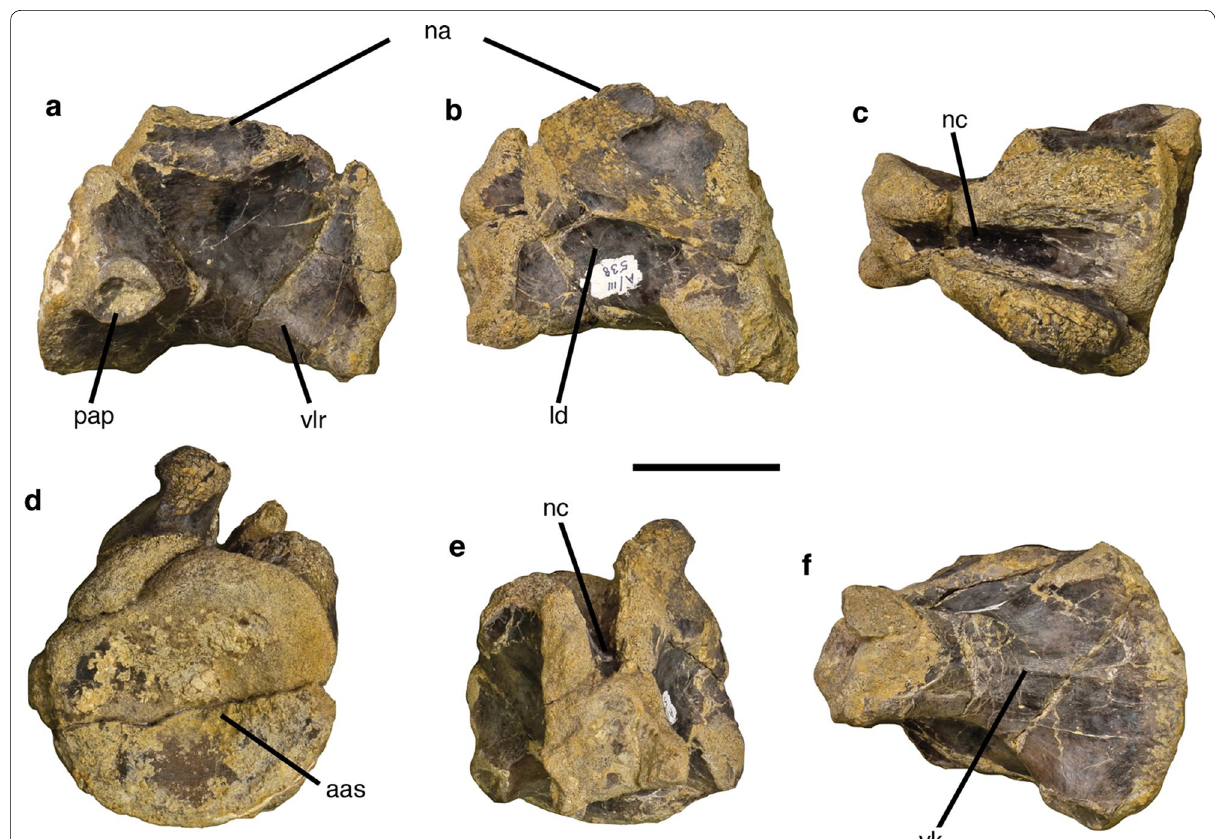
Fig. 3 Posterior cervical vertebra of Schleitheimia schutzi n. gen., n. sp., PIMUZ A/III 538. a , b left and right lateral views; c dorsal view; d anterior view; e posterior view; f ventral view. aas, anterior articular surface; na, neural arch; ld, lateral depression; nc, neural canal; pap, parapophysis; vk, ventral keel; vlr, ventrolateral ridge. Scale bar equals 5